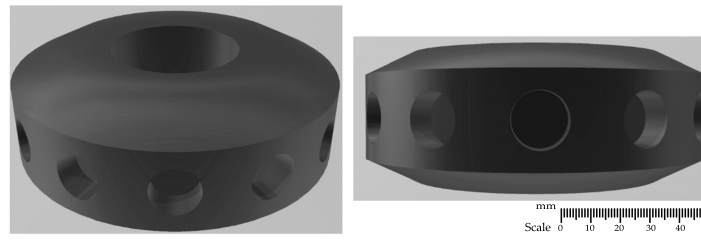
Figure 3. A 3D model—impeller with twelve holes—variant B12.